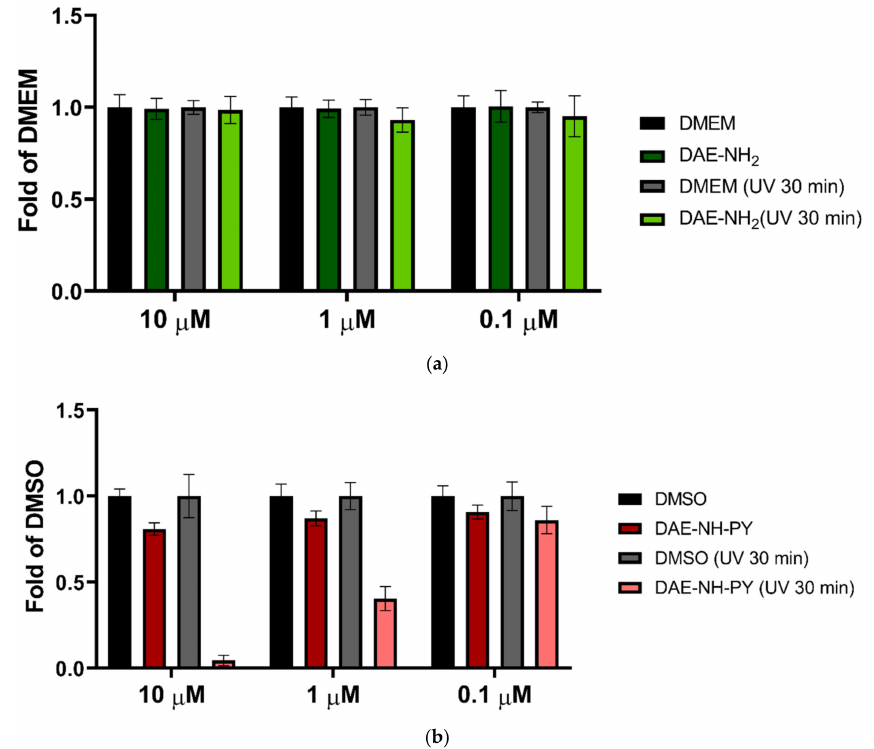
Figure 13. Cell survival of A549 cells treated with DAE-NH 2 ( a ) or DAE-NH-Py ( b ), with or without UV-A light irradiation (30 min each of three days of cell incubation). Control samples are cells treated with DMSO for DAE-NH-Py, or DMEM for DAE-NH 2 . Representative data of three independent experiments which yielded similar results are shown. Data are presented as relative to the control samples ± SD, made in three replicates.